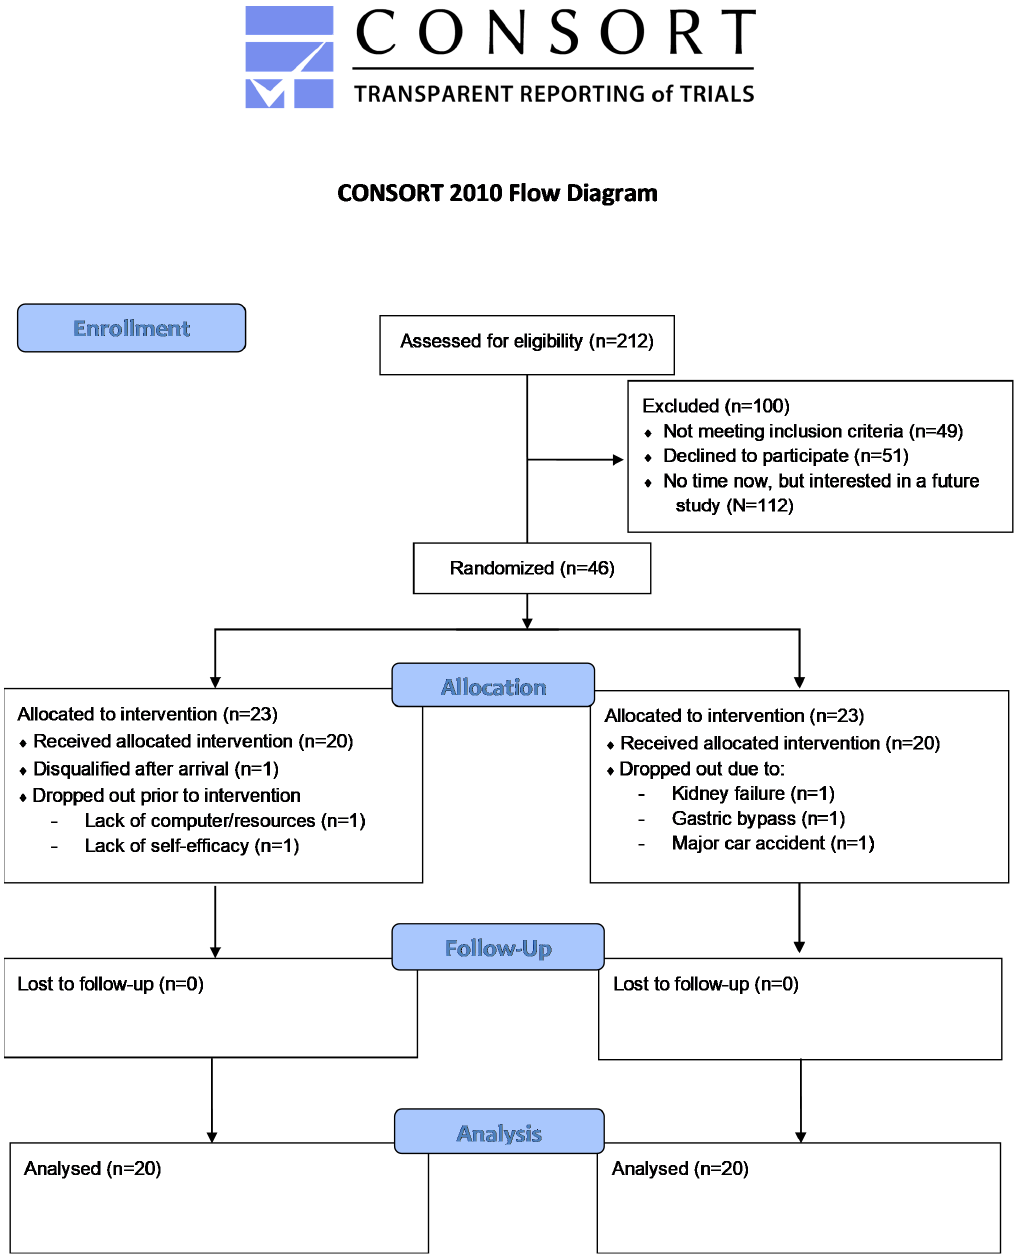
Figure A1. CONSORT diagram reporting the flow of recruitment, allocation, follow-up, and analysis for this clinical trial.